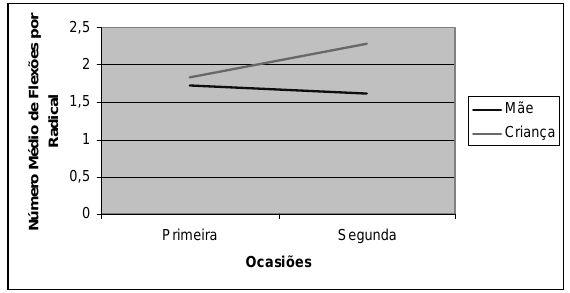
Figura 2 . Número médio de flexões por radical em função do participante e da